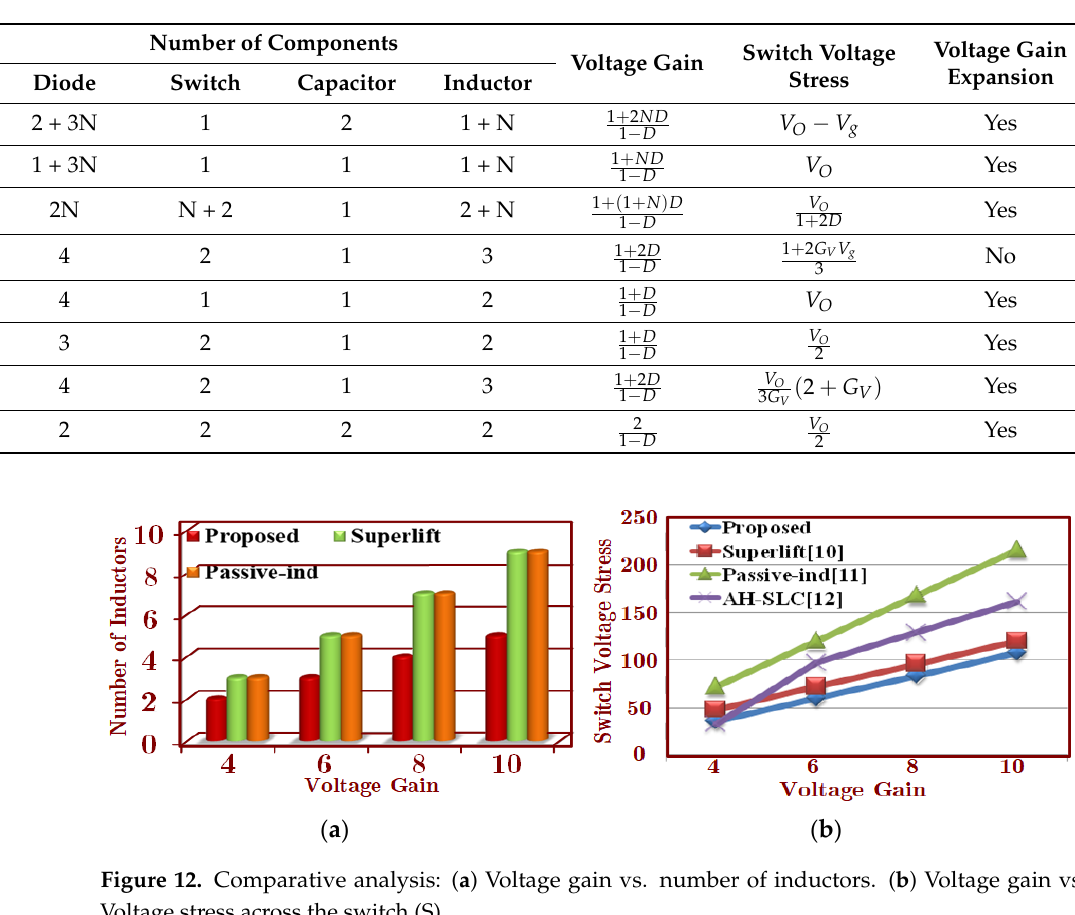
Table 4. Comparison of HSIVL converter with few high gain converters in the literature.